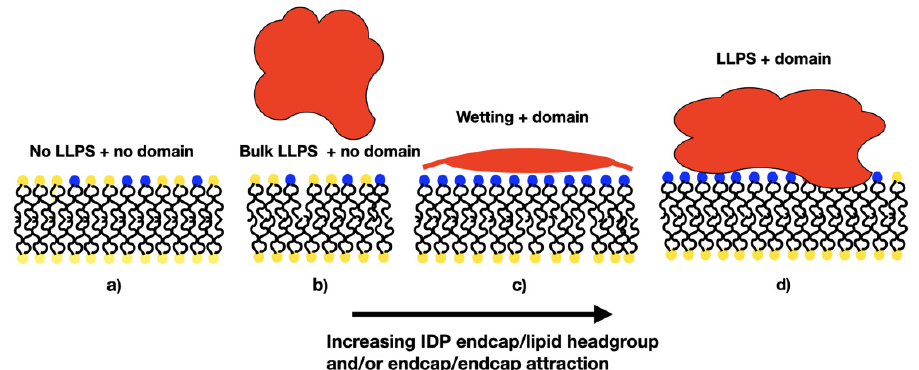
Figure 1. Cartoon showing potential morphologies of the bulk IDPs and two-component lipid membrane as the relative interactions between the IDPs (red) and the minority lipid headgroups (blue) are varied. ( a ) IDPs dispersed in the solvent; ( b ) high self-attraction; ( c )thin wetting layer; ( d ) minority phase lipid domain.